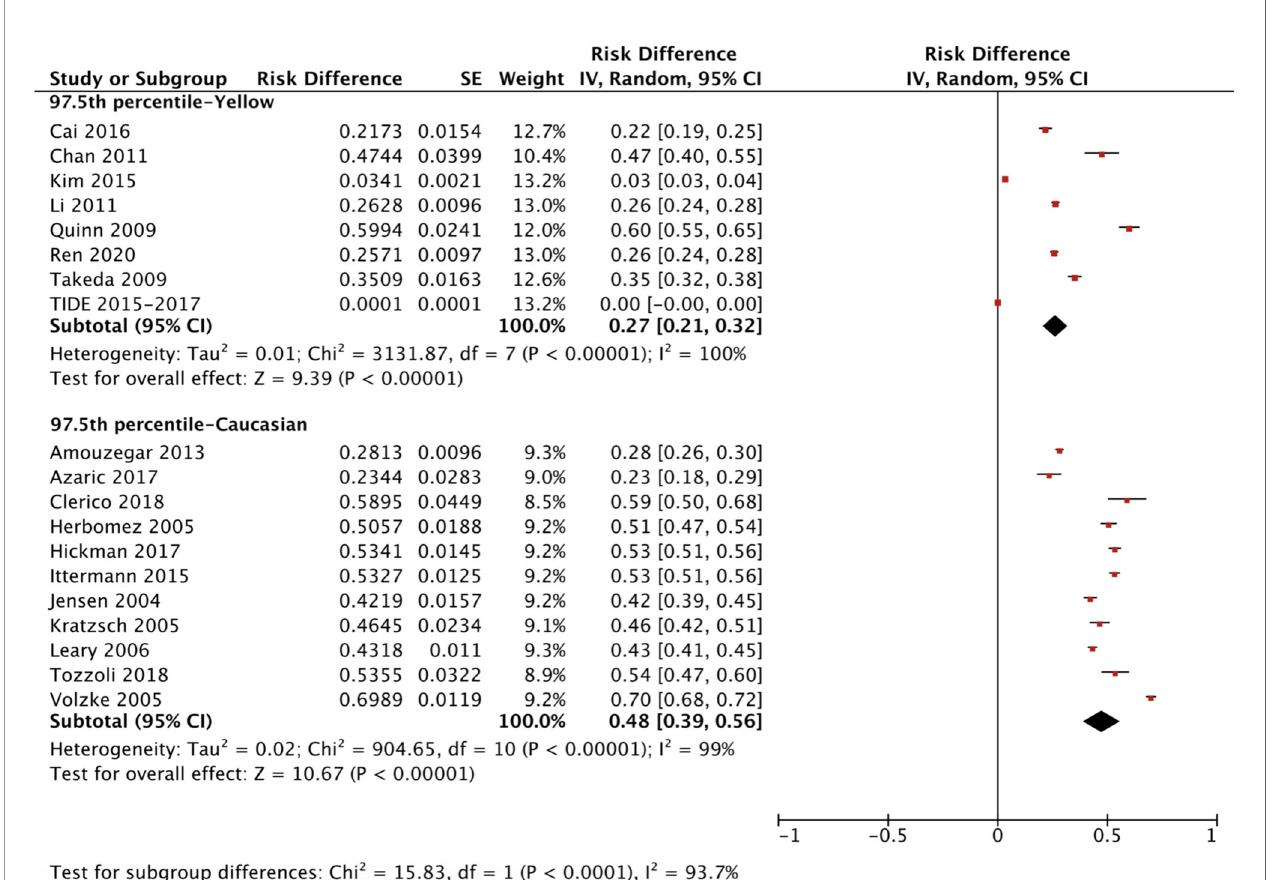
FIGURE 4 | Ethnicity standardized forest plots of the pooled relative descent rate (%) of TSH upper limits (97.5 th percentile) in NACB populations.